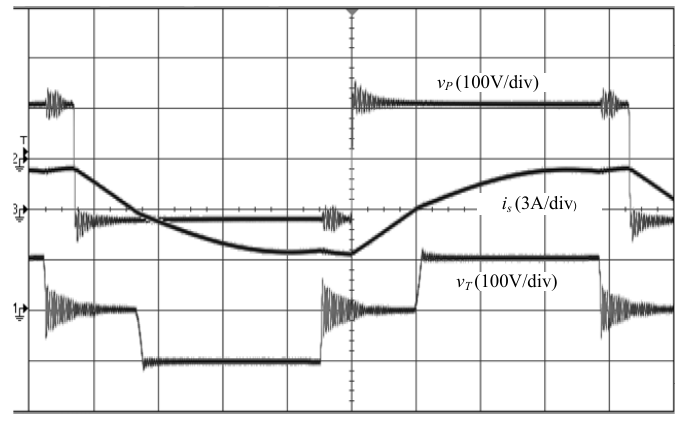
Figure 17. Experimental plot at: d < 1; V in = 120 V; V o = 100 V; P o = 270 W, CCM2 operation with φ > 0.